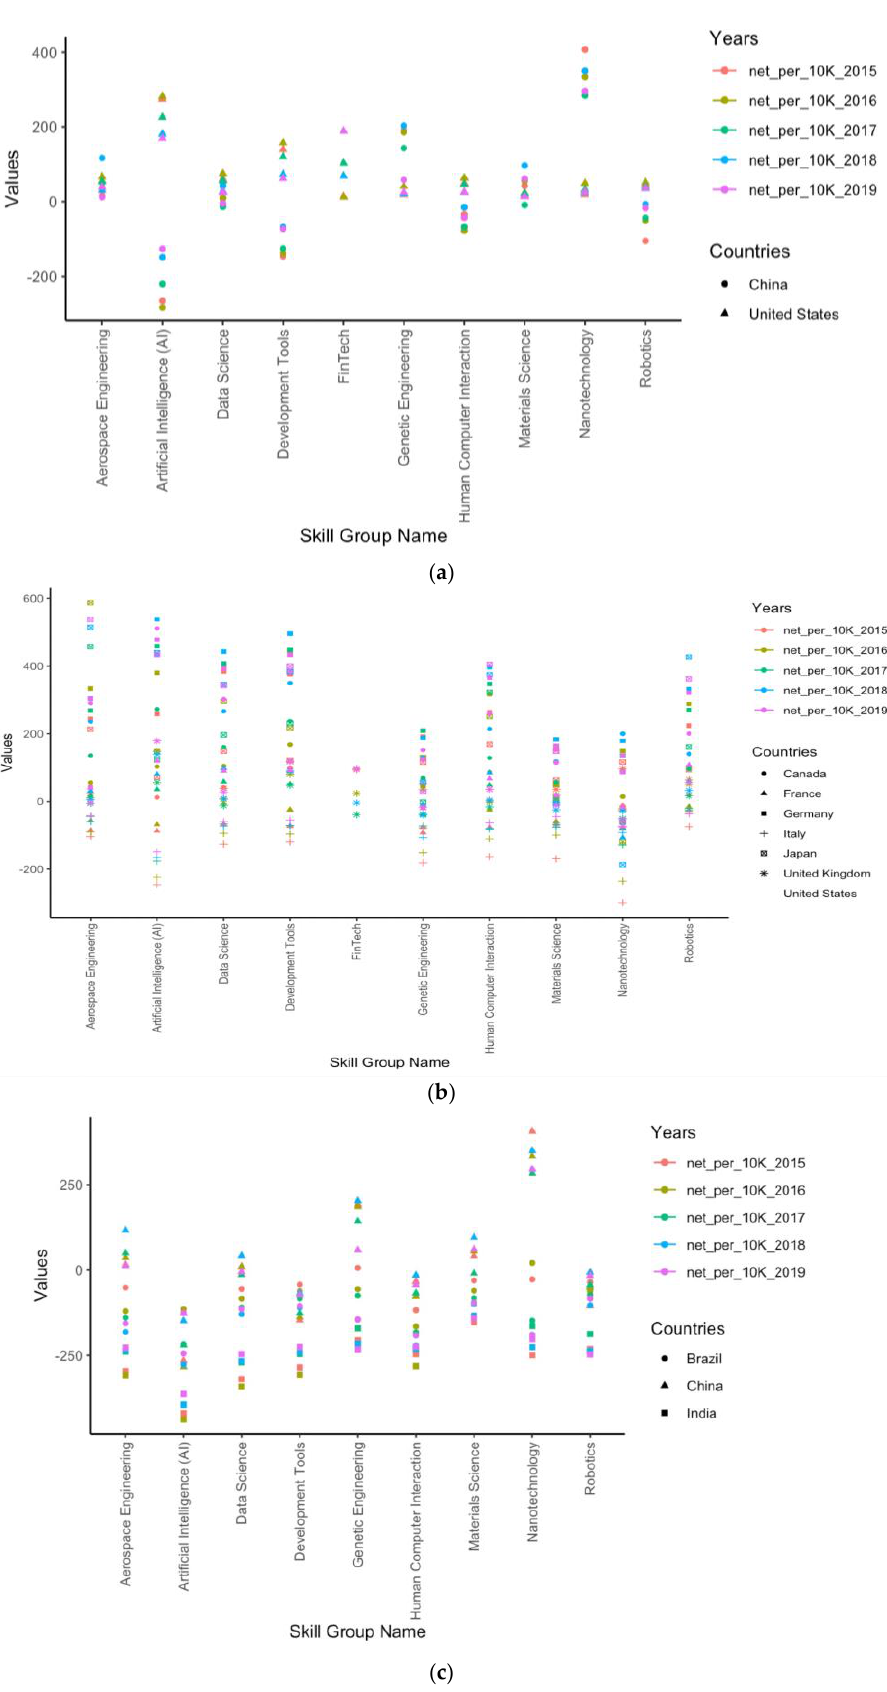
Figure 5. Disruptive-tech skills migration in ( a ) China and the US, ( b ) G7 countries, and ( c ) BIC countries.